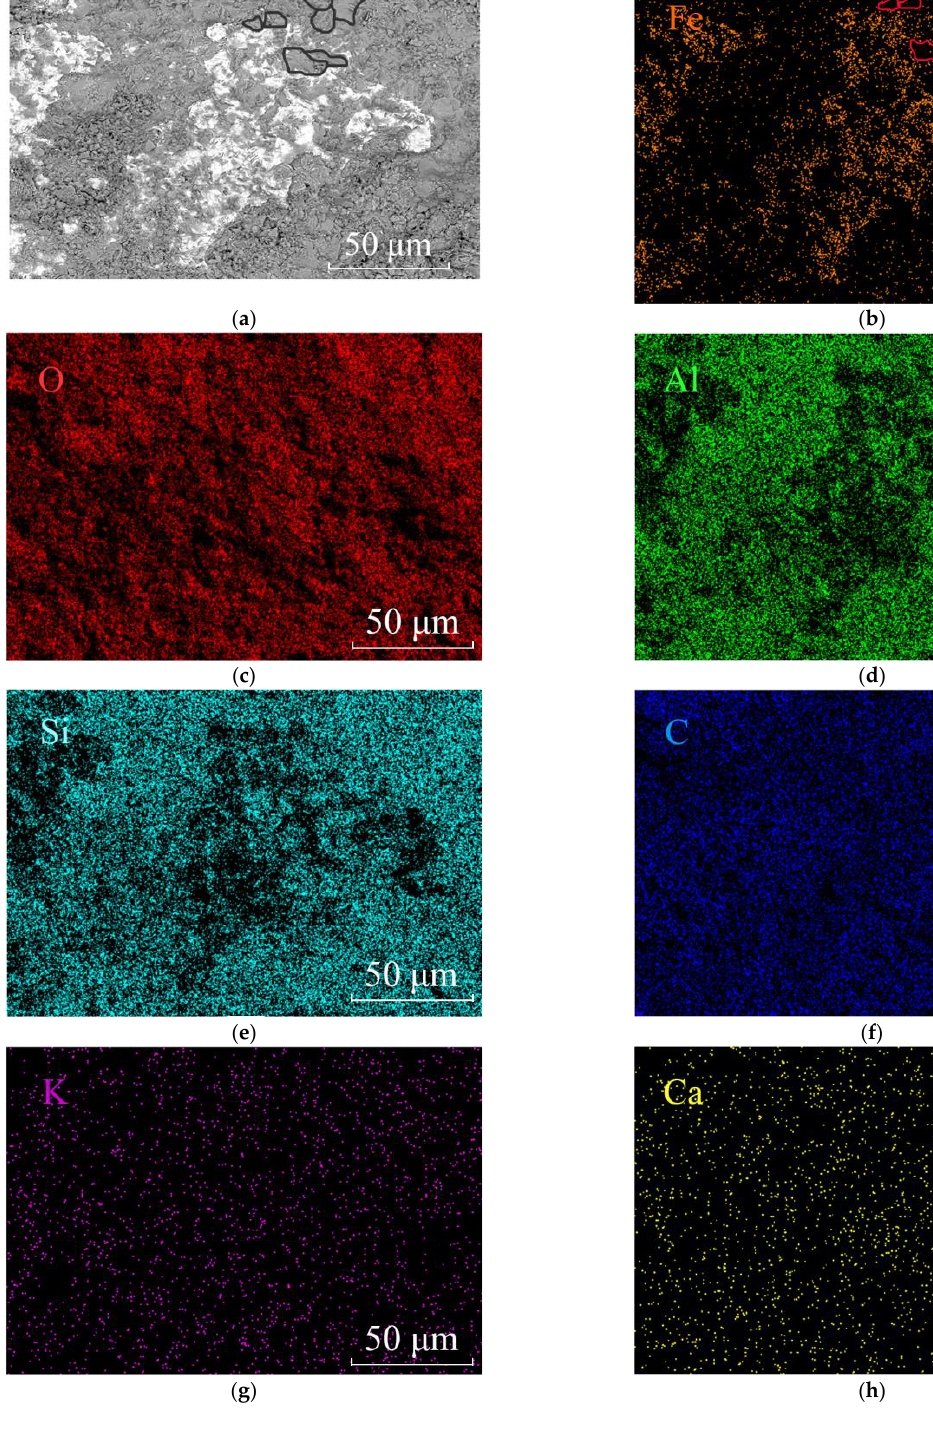
Figure 7. SEM and EDS mapping of iron oxide or hydroxide minerals in plate-like dickite particles. ( a ) SEM image showing the platy ferruginuous minerals distributed among dickite particles. Some dickite particles were circles black in the upper; ( b ) Element Fe distribution map. Fe concentrates in the iron oxides/hydroxides and outlines the dickite particles, such as the red circles shown ; ( c ) Element O distribution map; ( d ) Element Al distribution map; ( e ) Element Si distribution map; ( f ) Element C distribution map; ( g ) Element K distribution map and ( h ) Element Ca distribution map of the same area of ( a ).